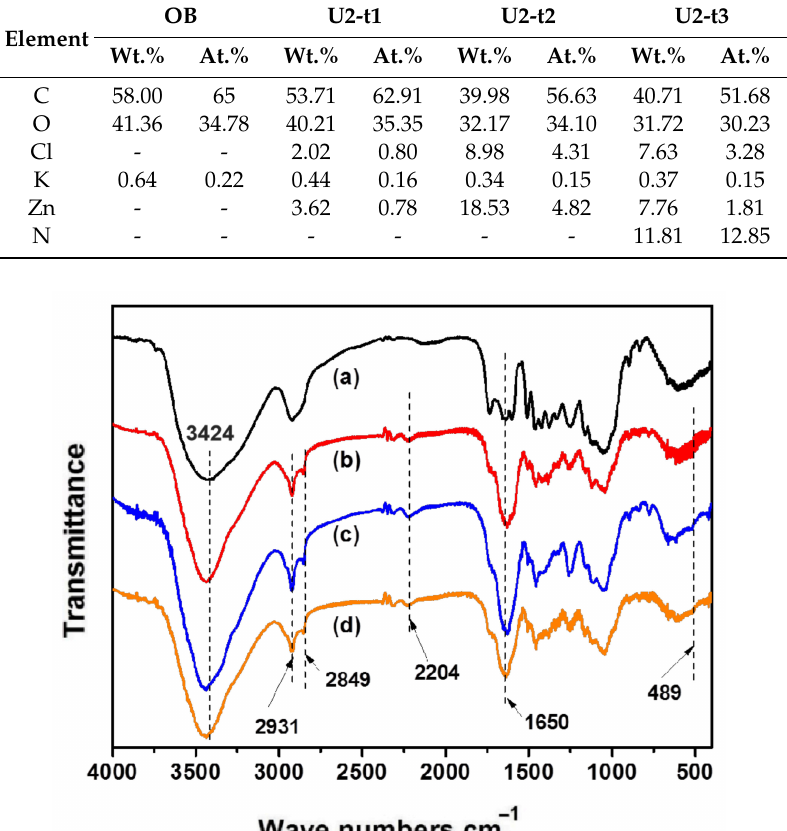
Figure 5. Infrared spectrum of bamboo surface before and after treated: ( a ) OB, ( b ) U2-t1, ( c ) U2-t2, ( d )